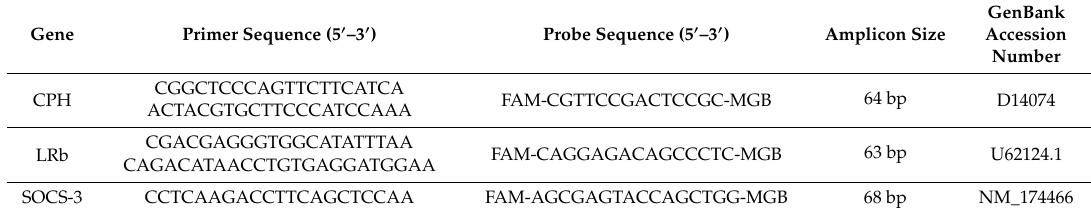
Table 3. Characteristics of primers and probes used to determine cyclophilin (CPH; reference gene), the long form of the leptin receptor (LRb; target gene) and a suppressor of cytokine signaling-3 (SOCS-3; target gene) mRNA expression in